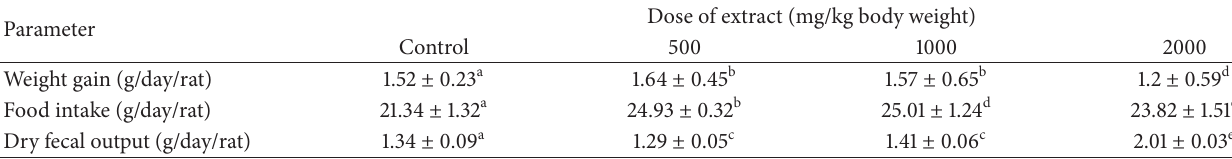
Table 2: Weight gain, food consumption, and fecal output of rats administered J. curcas extract ( 𝑛 = 6 , mean ± SD).